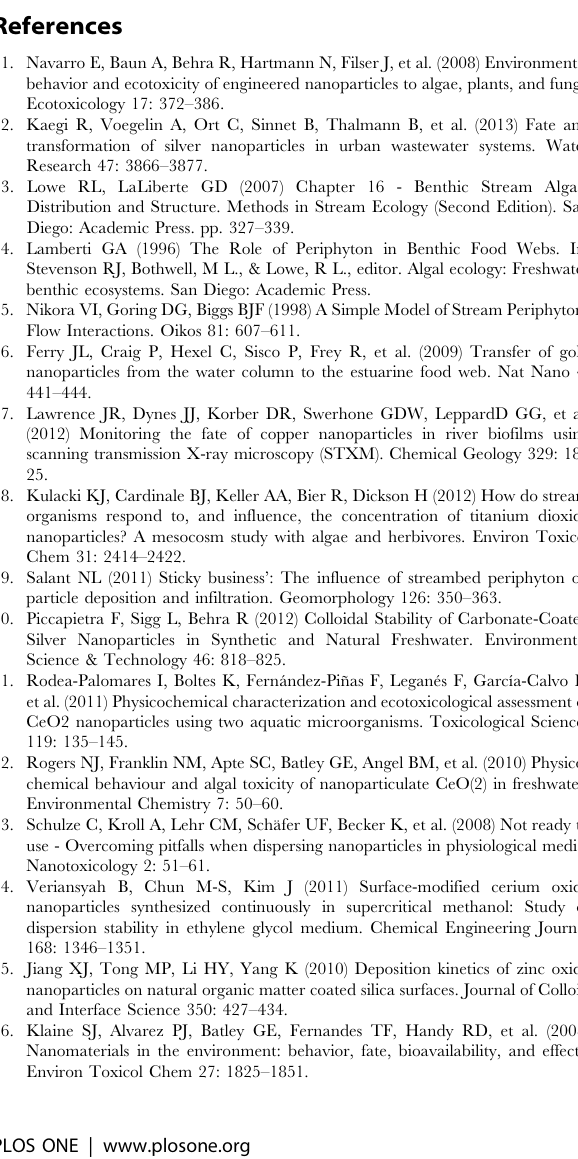
Table S11 Mean Z-averages (DLS), polydispersity (PDI), mode and mean diameters (NTA), zetapotential, and EPM of Ag NP dispersions dependent on pH, light/dark, EPS content, and time. Each value is derived from three measurements of three replicates (3x 3n). Blue: data used to calculate mean values represented in Figures 4 A–D. Table S12 Standard deviations of Z-averages (DLS), polydis- persity (PDI), mode and mean diameters (NTA), zetapotential, and EPM of Ag NP dispersions dependent on pH, light/dark, EPS content, and time. Table S13 Z-averages (DLS), polydispersity (PDI), mode and mean diameters (NTA), zetapotential, and EPM of NP formed in AgNO 3 solutions dependent on pH, light/dark, EPS content, and time. ns: no signal. Each value is derived from three measurements of three replicates (3x 3n). blue: data used to calculate mean values represented in Figures 8 A–C. Table S14 Standard deviations of Z-averages (DLS), polydis- persity (PDI), mode and mean diameters (NTA), zetapotential, and